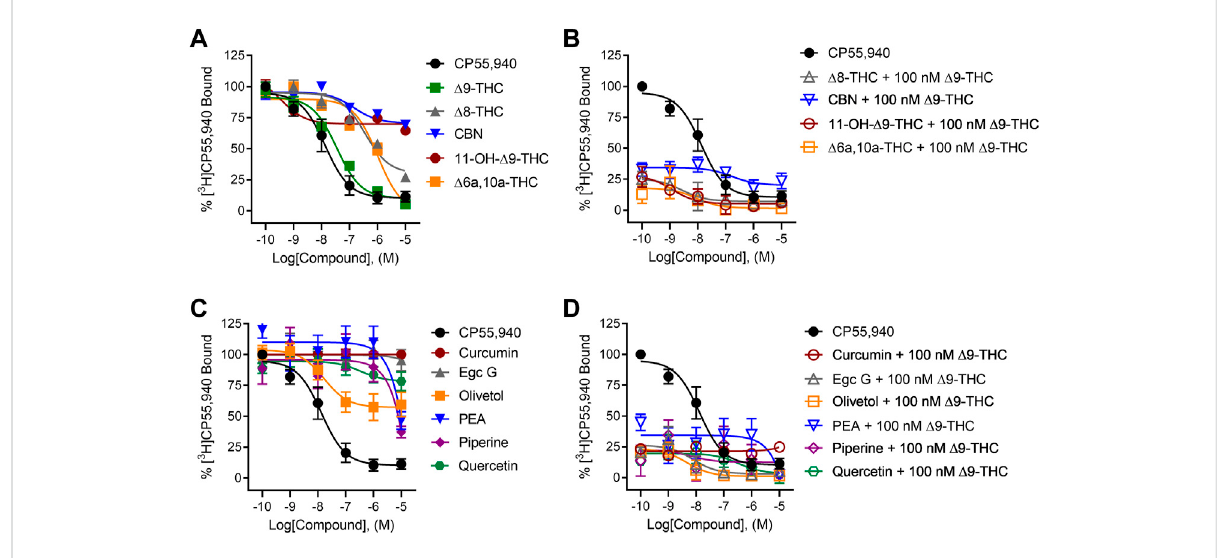
FIGURE 2 [ 3 H]CP55,940displacementfromhCB1RCHOcellmembranes.Compoundactivitywasquanti fi edfor[ 3 H]CP55,940bindinginCHOcellsstably expressing hCB1R and treated with 0.1 nM — 10 µM (A) cannabinoids; (B) cannabinoids + 100 nM Δ 9 -THC; (C) phytomolecules; and (D) phytomolecules + 100 nM Δ 9 -THC. Data were fi t to a variable slope (four parameters) non-linear regression in GraphPad (v. 9). n ≥ 6 independent experiments were performed in duplicate. Data are expressed as mean ± SEM. K i and E min are reported in Table